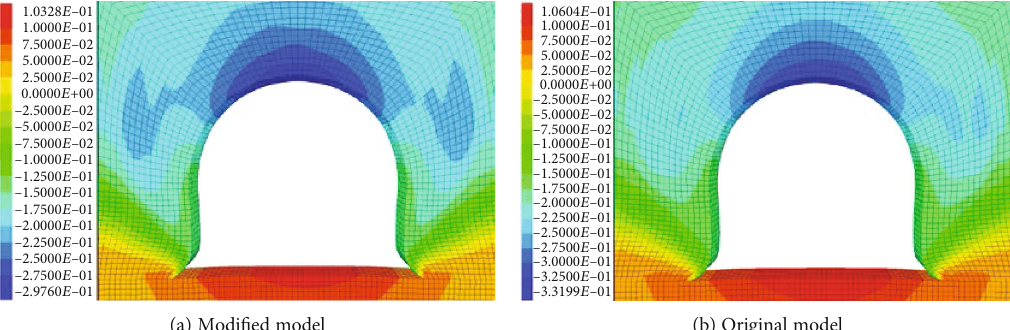
Figure 15: The vertical displacement contour of the surrounding rock masses when the modi fi ed model and the original model arrive at the calculation balance.